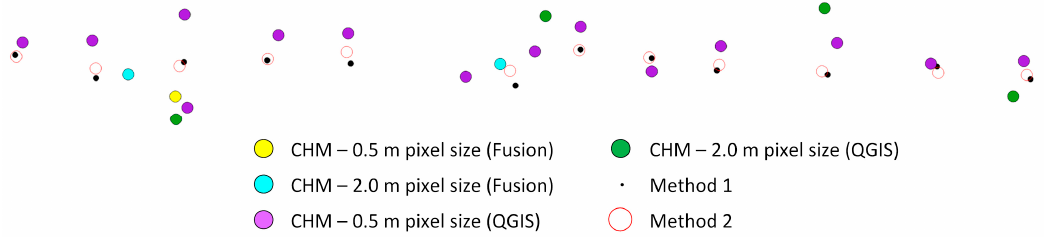
Figure 10. Sample of the position of detected trees for each method.